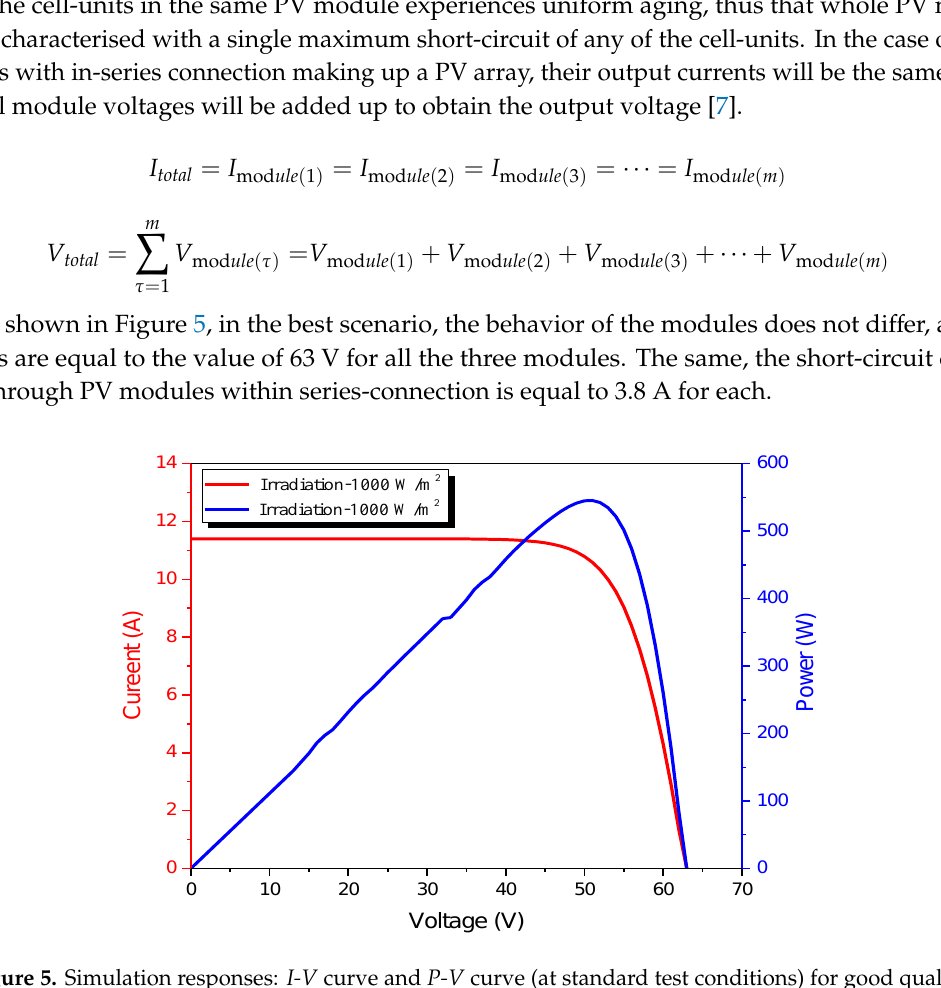
Figure 5. Simulation responses: I-V curve and P-V curve (at standard test conditions) for good quality modules of Solarex MSX60 connected in series.